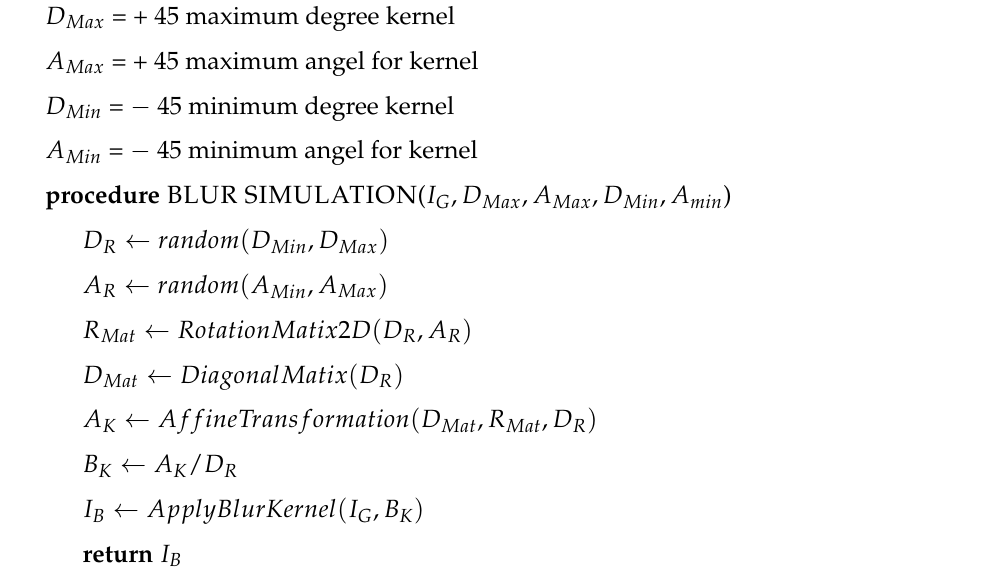
Algorithm 1 Simulating motion blurs on medical